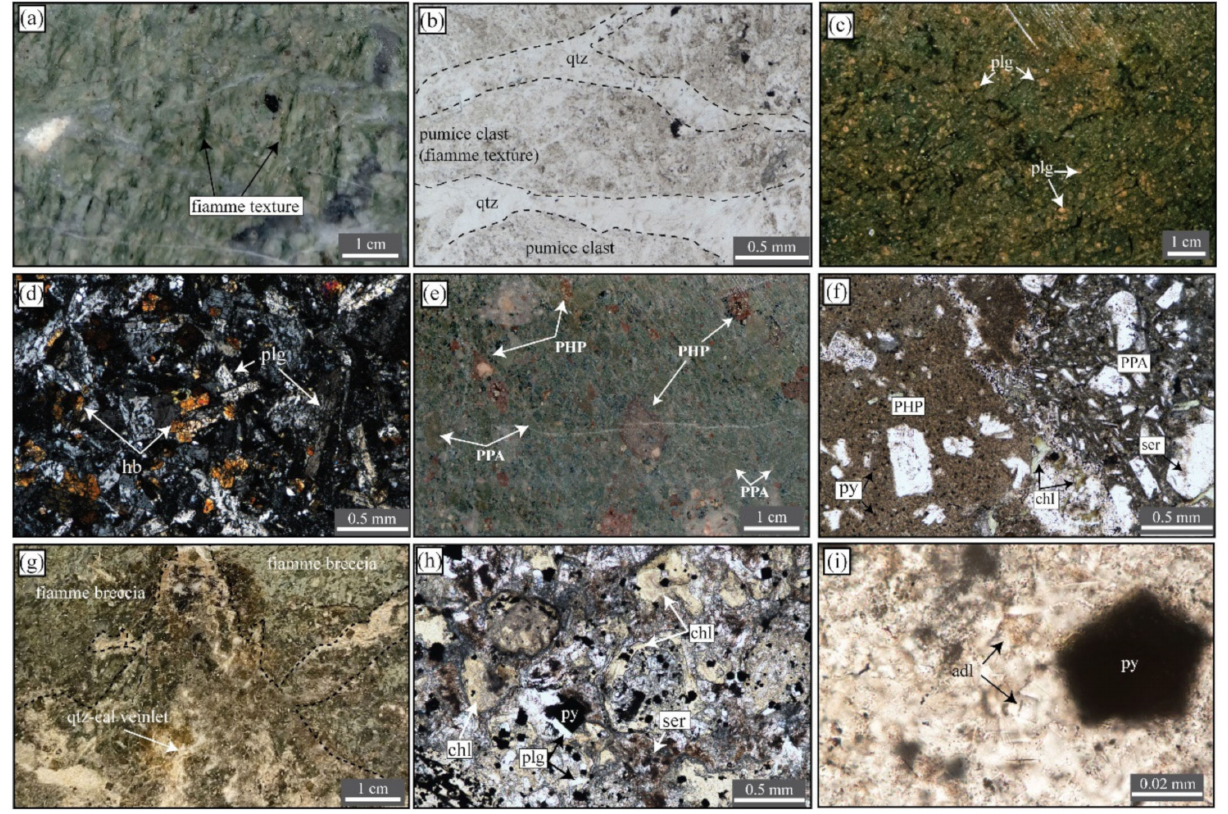
Figure 3. Photograph and photomicrograph of representative host rock samples. ( a ) Photograph of rhyolitic fiamme breccia showing a flame-like texture (fiamme). ( b ) Photomicrograph of rhyolitic fiamme breccia showing quartz crystals and pumice clasts (PPL). ( c ) Photograph of plagioclase phyric andesite. ( d ) Photomicrograph of plagioclase phyric andesite showing plagioclase and py- roxene phenocrysts (XPL). ( e ) Photograph of polymictic mafic-intermediate breccia showing clasts of plagioclase-hornblende phyric andesite and plagioclase phyric andesite. ( f ) Photomicrograph of polymictic mafic-intermediate breccia showing clasts in several types, such as plagioclase-hornblende phyric andesite, plagioclase phyric andesite, and sandstone (PPL). ( g ) Photograph of lithic-rich fiamme breccia showing intense alteration in the rock. ( h ) Photomicrograph of lithic-rich fiamme breccia showing an abundance of alteration minerals, such as sericite, chlorite, and pyrite. ( i ) Pho- tomicrograph of lithic-rich fiamme breccia showing adularia and pyrite as alteration minerals that occurred close to the veins. Abbreviations: chl = chlorite, py = pyrite, plg = plagioclase, hb = horn- blende, qtz = quartz, ser = sericite PHP = plagioclase-hornblende phyric andesite, PPA = plagioclase phyric andesite, adl =